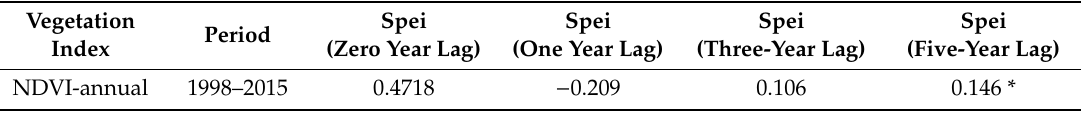
Table 3. Spearman’s correlation coe ffi cients for the vegetation index and SPEI of the NXC.